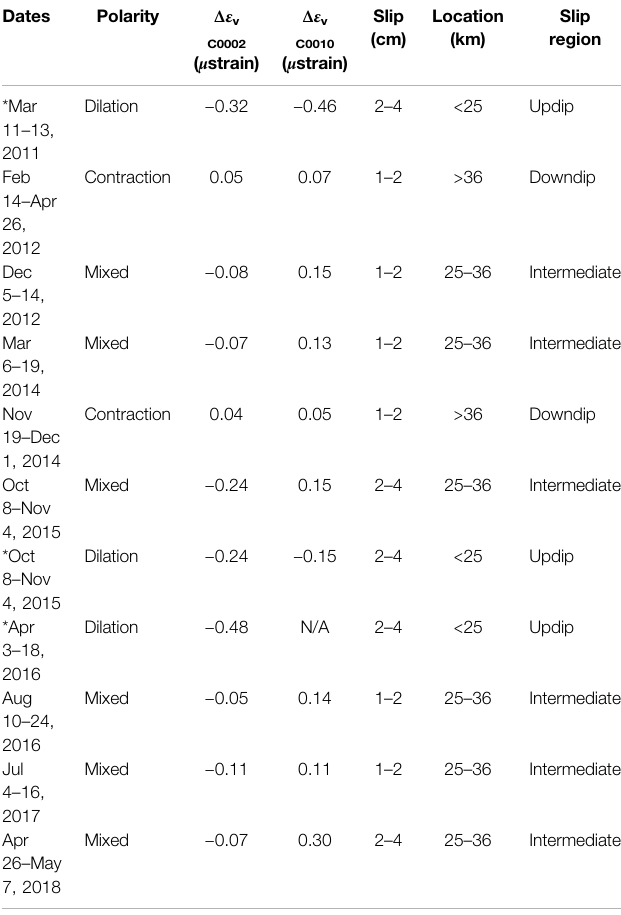
Δ ε v : the compressional volumetric strain is positive, whereas the dilatational one is negative. Location: distance from the center for the slip region of 20 – 40 km width to the trench landward, as shown by the equidistant lines in Figure 4B . Shaded region: the result from Araki et al. (2017). *SSE accompanied by